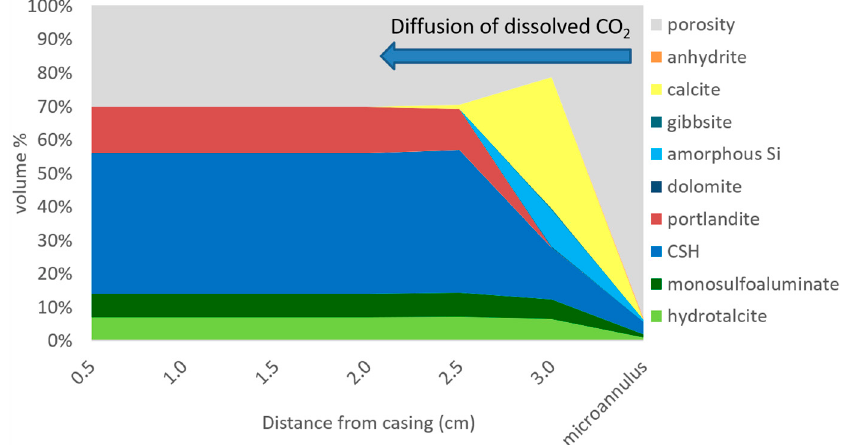
Figure 2. The cement mineralogy and porosity after two years of CO 2 leakage are plotted for a horizontal transect across the cement sheet and the microannulus, located just above the CO 2 reservoir. Cement reacts with CO 2 from the microannulus on the right. Note that, even though not well visible, small amounts of dolomite, anhydrite and gibbsite precipitate in the microannulus and cement. After the CO 2 within the microannulus reached the top of the caprock, the pH is around 4.5 throughout the microannulus. In the cement a ff ected by CO 2 interactions-adjacent to the microannulus-the pH is roughly 5 and in the unaltered cement nearly 11 (Figure 3). The pH